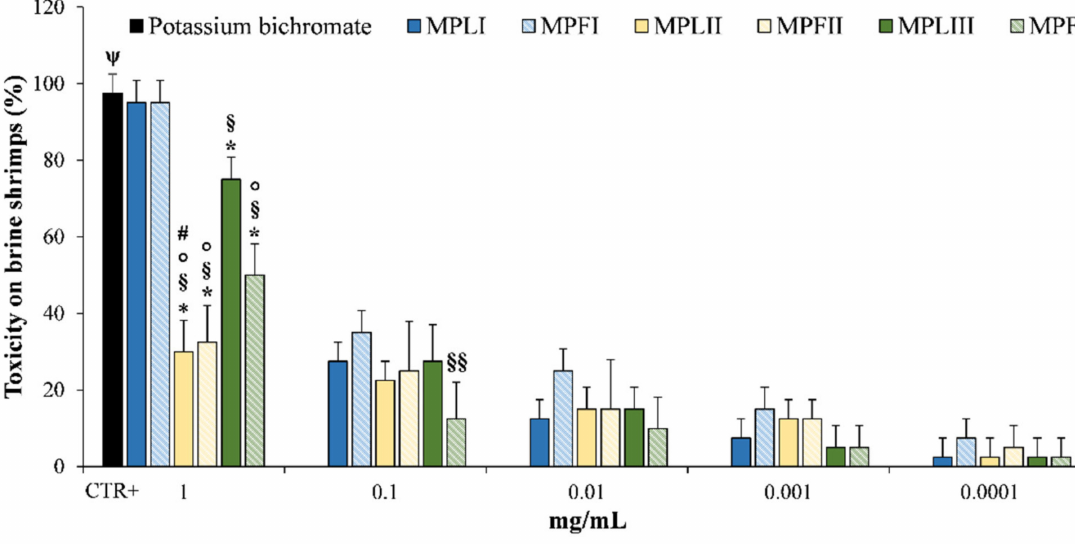
Figure 10. Toxicity on brine shrimps ( Artemia salina ) by EOs of M. pulegium leaves (MPLI, MPLII, and MPLIII) and flowers (MPFI, MPFII, and MPFIII) at 48 h. Potassium bichromate (50 µ g/mL) was used as a positive control (CTR+). Results are the mean of three independent experiments ± standard deviation ( n = 10). * p < 0.001 vs. MPLI; § p < 0.001 vs. MPFI; §§ p < 0.05 vs. MPFI ◦ p < 0.001 vs. MPLIII; # p < 0.05 vs. MPFIII; ψ p < 0.001 vs. all sample concentrations except MPLI and MPFI.